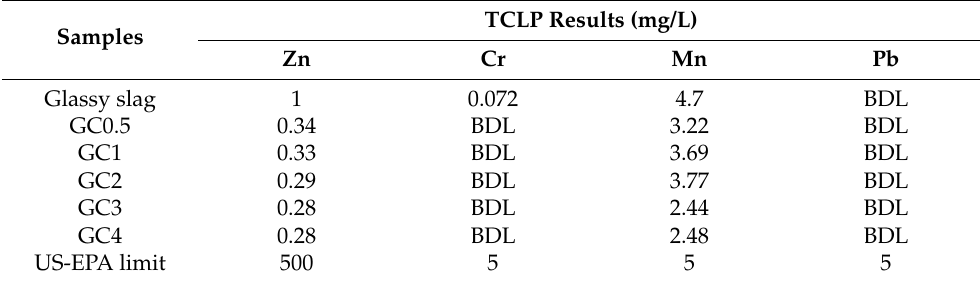
Figure 5. Simulation of the reaction equilibrium ( a ) and XRD results of the obtained slag ( b ) and PGM-bearing alloy ( c ) for confirmation experiment. Table 3. TCLP results of produced glassy slag